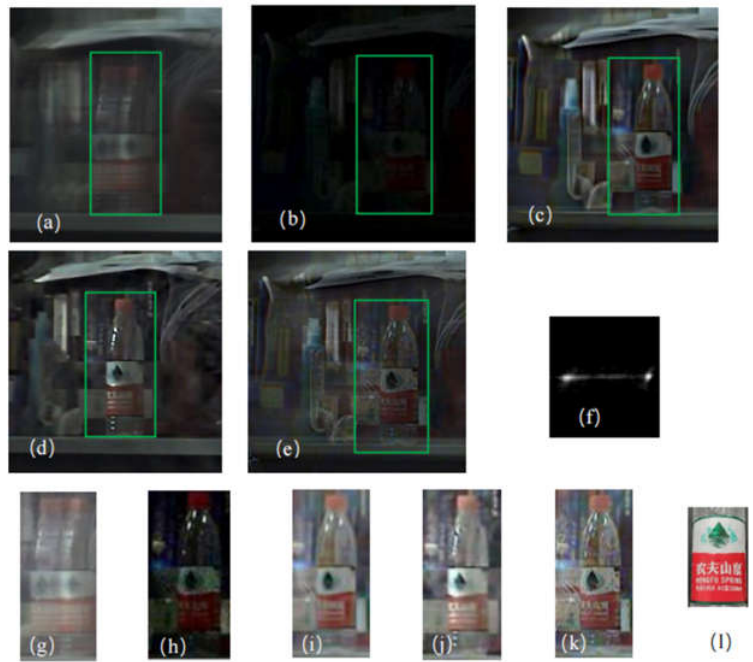
Figure 9. Real image results, the important part of the image comprises the Chinese characters as shown in ( l ): ( a ) blurred image; ( b ) short exposure image; ( c ) algorithm restored image in [27]; ( d ) algorithm restored image in [11]; ( e ) the restoration result of this algorithm; ( f ) result of kernel; ( g ) blurred image; ( h ) short exposure image; ( i ) algorithm restored image in [27]; ( j ) algorithm restored image in [11]; ( k ) algorithm proposed in this paper; ( l ) details of the Chinese